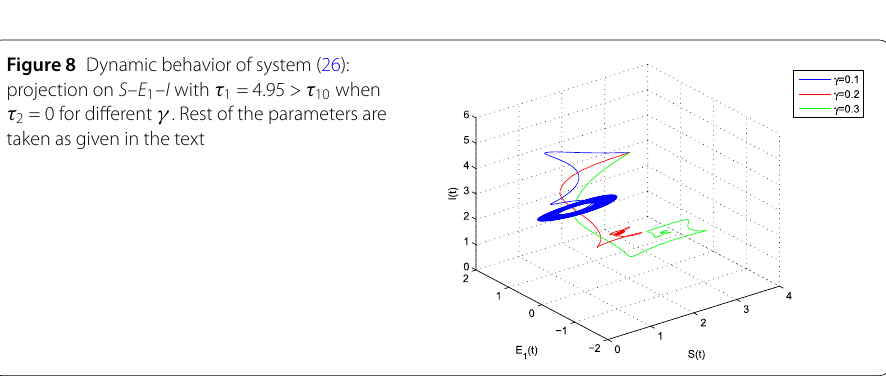
Figure 7 Time plots of S , E 1 E 2 and I for different γ at τ 1 = 4.25 when τ 2 = 0. Rest of the parameters are taken as given in the text